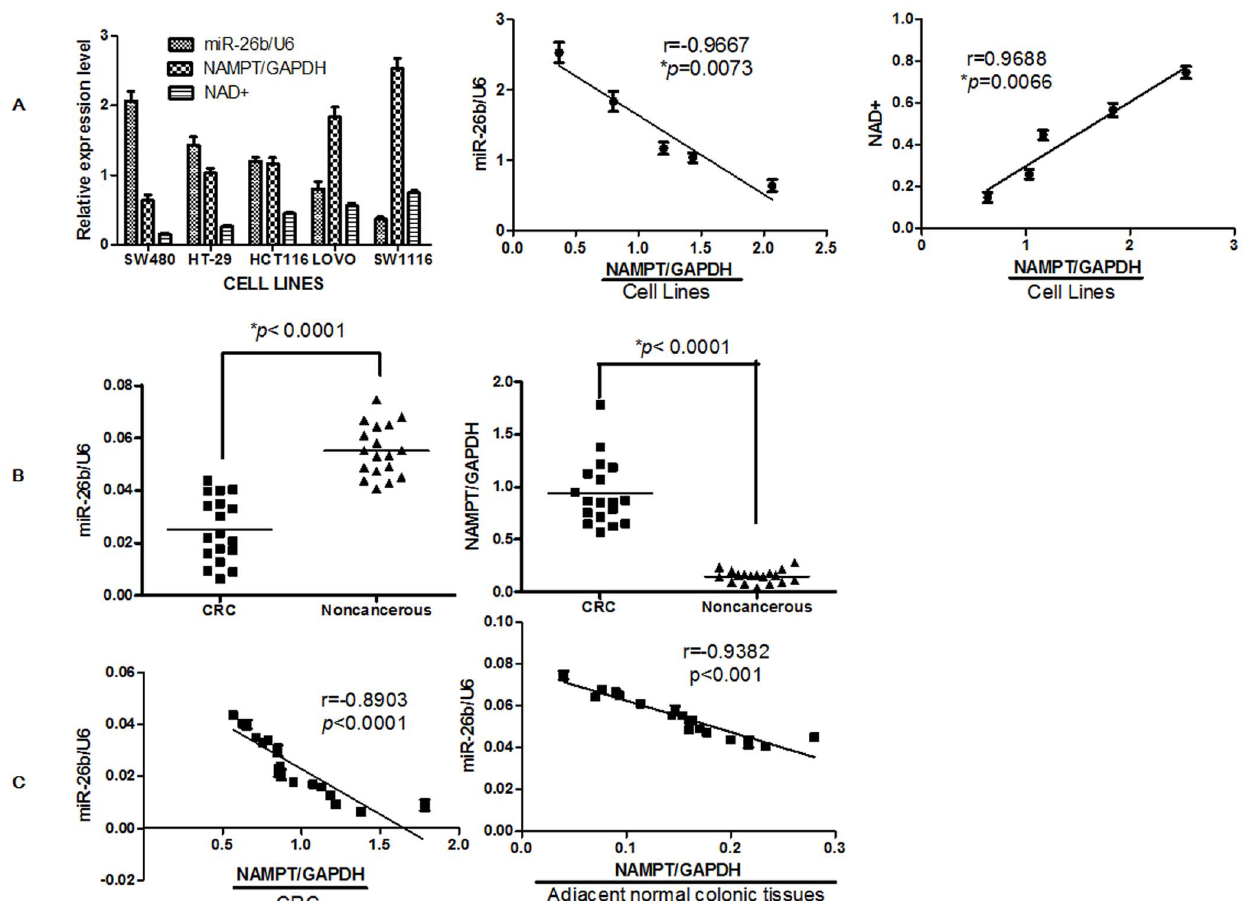
Figure 3. Nampt mRNA levels were inversely correlated with miR-26b levels in colorectal cancer cell lines and patient samples. A. miR-26b, Nampt mRNA and NAD + levels were assayed in colorectal cancer cell lines. The expression of miR-26b was inversely correlated with Nampt expression in colorectal cancer cell lines; the expression of NAD + was positive correlated with Nampt expression in colorectal cancer cell lines (A right). B. miR-26b and Nampt mRNA levels were assayed in 18 surgical specimens of human colorectal cancer tissues and adjacent normal colorectal tissues. Significantly upregulated Nampt levels in colorectal cancer tissues are shown relative to Nampt levels in adjacent normal colorectal tissues (fold changes . 6); significantly downregulated miR-26b levels in colorectal cancer tissues are shown relative to miR-26b levels in adjacent normal colorectal tissues (fold changes . 2). C. The expression of miR-26b was inversely correlated with Nampt expression in colorectal cancer tissues (C left), and adjacent normal colorectal tissues (C right). Nampt mRNA levels were assayed by real-time RT-PCR and normalized to GAPDH. The miR-26b levels were assayed by real-time RT-PCR and normalized to U6. Each vertical bar represents the mean 6 SD of triplicate determinations. For comparison of 2 groups, a two-tailed, unpaired t-test was